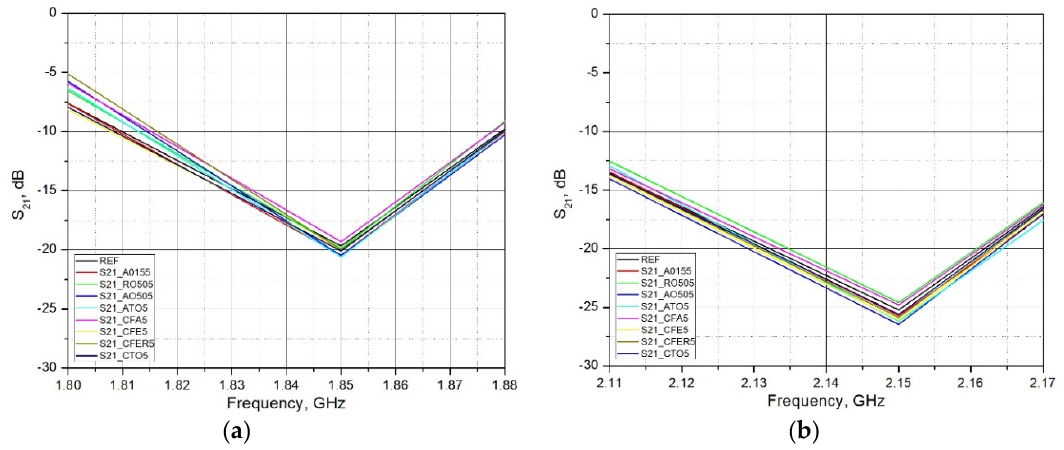
Figure 8. Measured S 21 parameter of brick samples in a frequency range 1.5 to 6 GHz, (d = 18 mm; 2r = 150 mm).